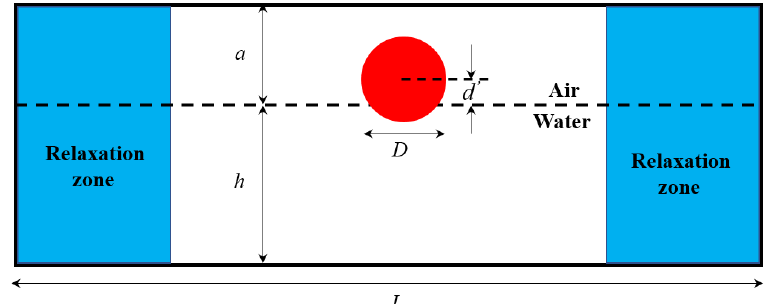
Figure 1. Schematic diagram of the numerical zone for the horizontal